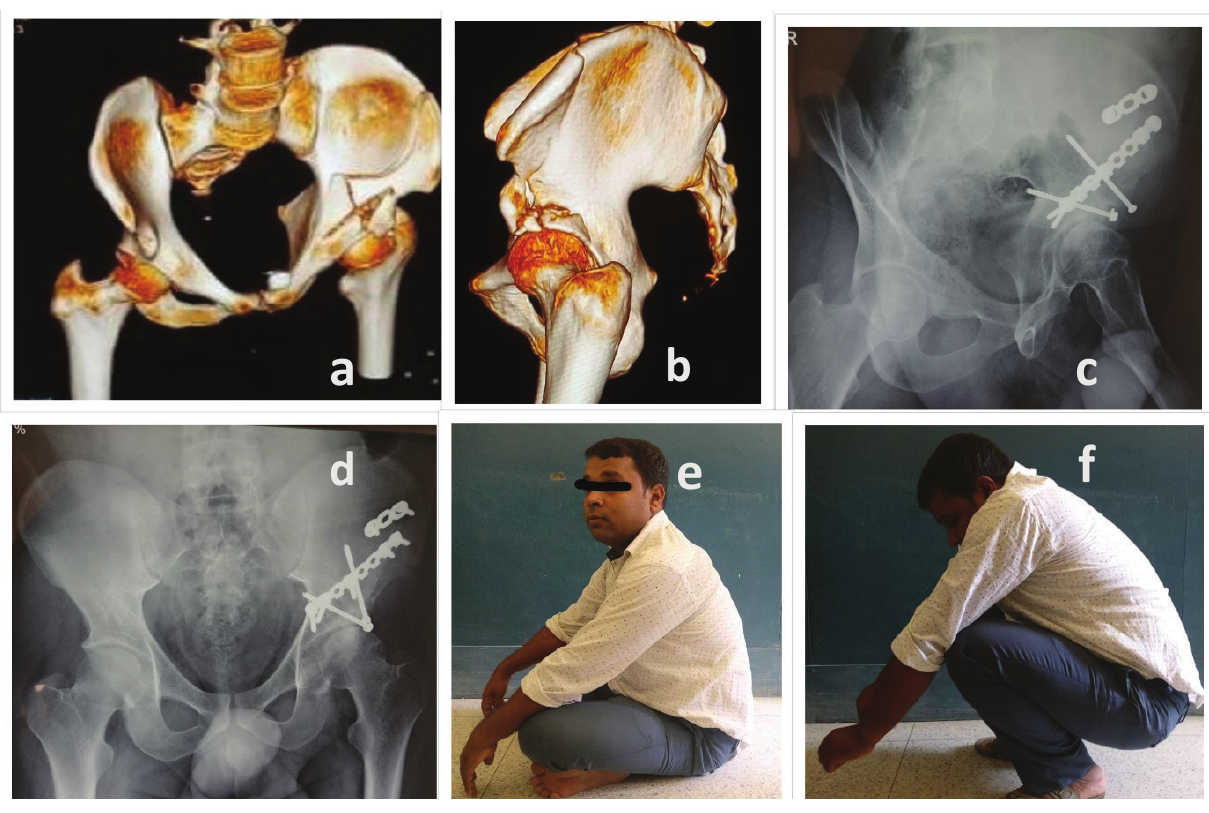
Figure: 1.a,b 3-D CT reconstruction view of anterior column and posterior wall injury. c,dXray at final follow-up. e,f clinical photos at final follow up 18 months.